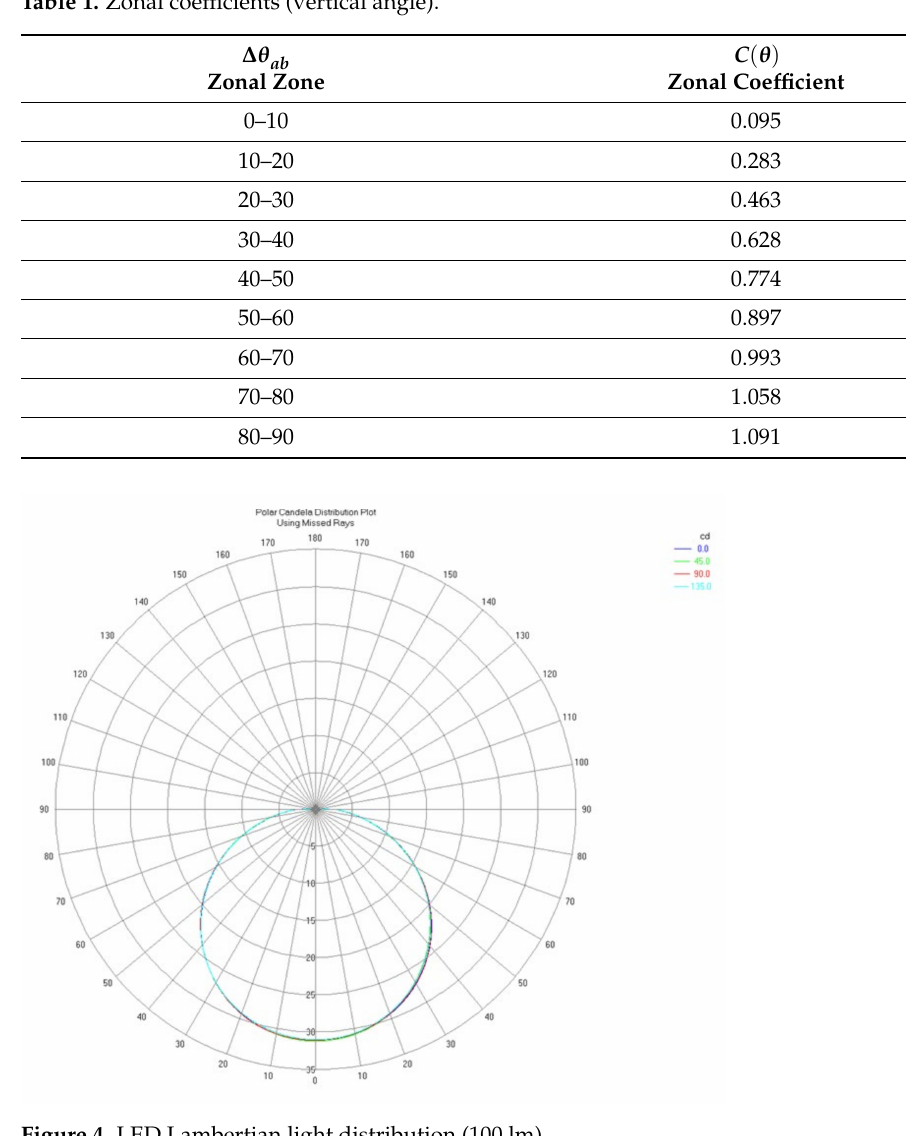
Figure 4. LED Lambertian light distribution (100